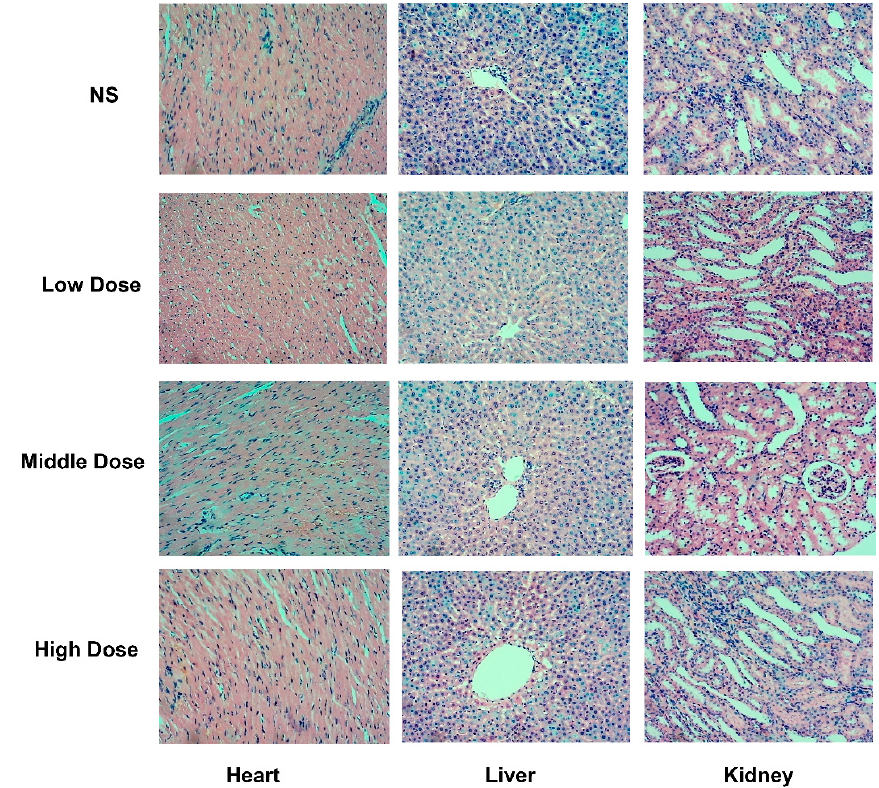
Figure 2. Pathological examination of heart, kidney and liver tissue after the administration of Radix Aconiti ethanol extraction. NS: Normal Saline; Low Dose: 2 g/kg ethanol extraction; Middle Dose: 5 g/kg ethanol extraction; High Dose: 10 g/kg ethanol extraction (10× magnification). Table 1. Mass measurement for exogenous metabolites of Radix Aconiti ethanol extraction.